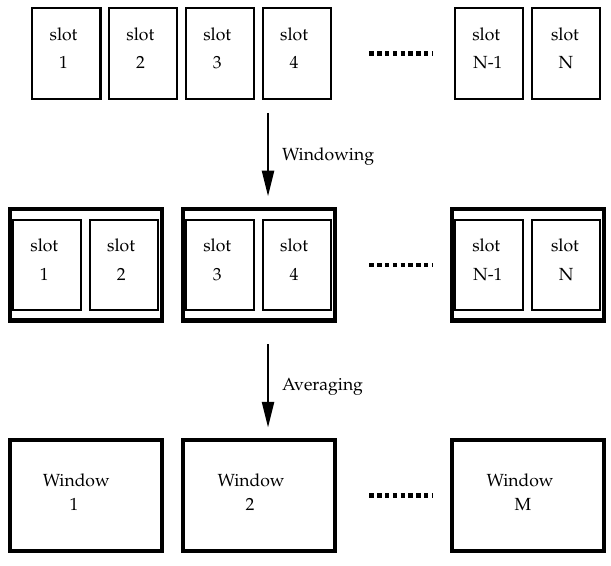
Figure 3. The windowing process.